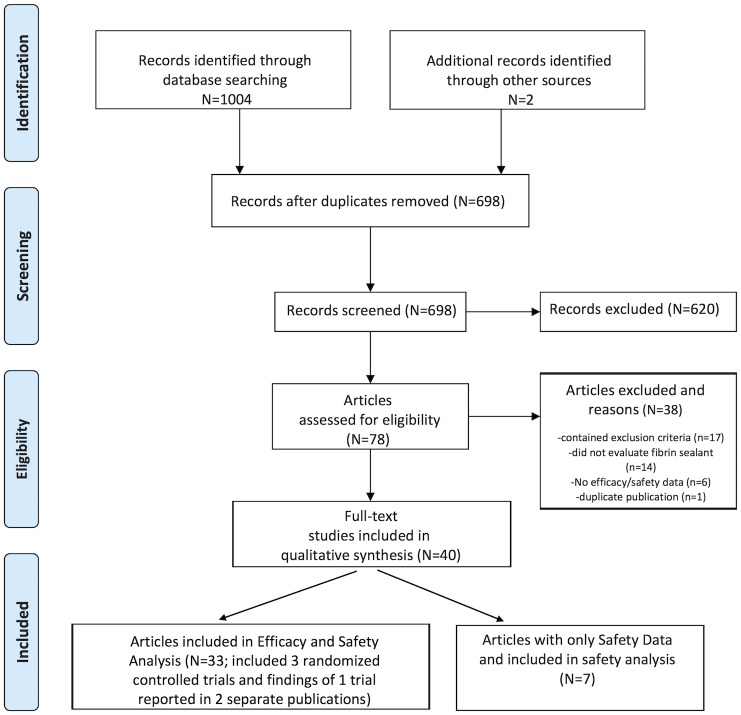
PRISMA Flow Diagram of the Selection Process to Identify Studies for Review.